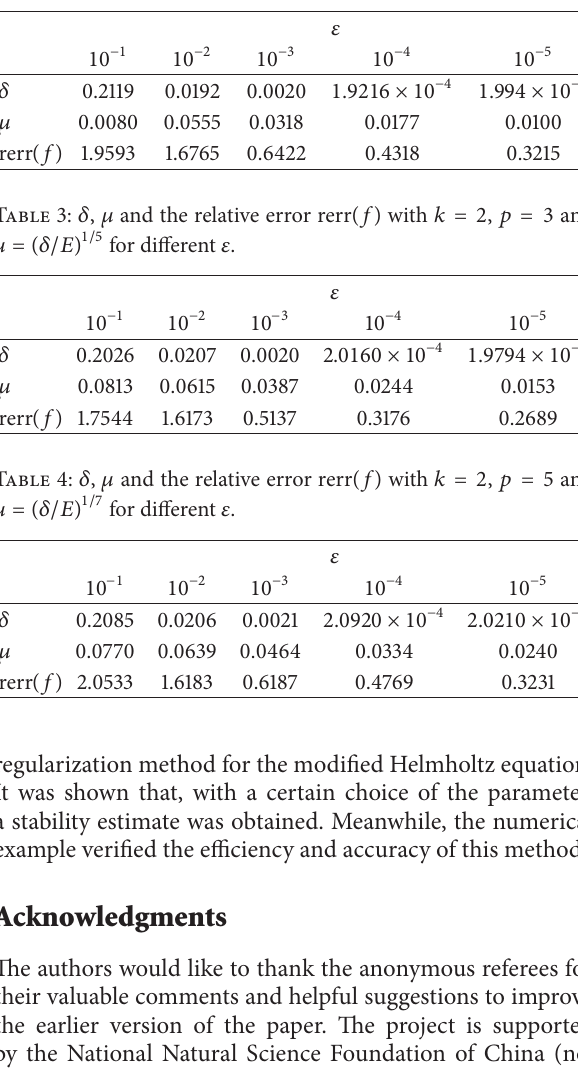
Table 2: 𝛿 , 𝜇 and the relative error rerr( 𝑓 ) with 𝑘 = 2 , 𝑝 = 2 and 𝜇 = (𝛿/𝐸) 1/4 for different 𝜀 .